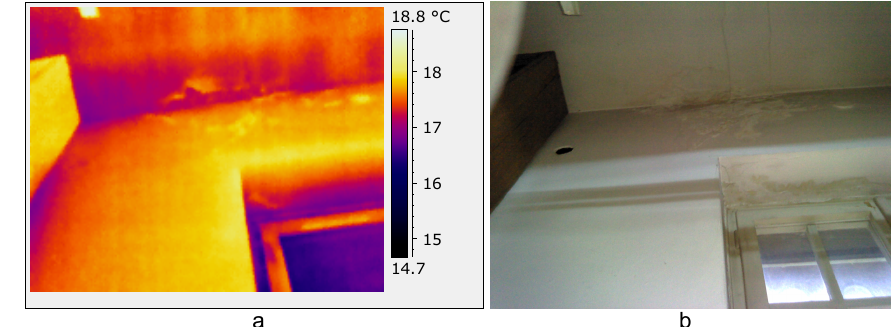
Figure 2 – Part of the wall above the first left